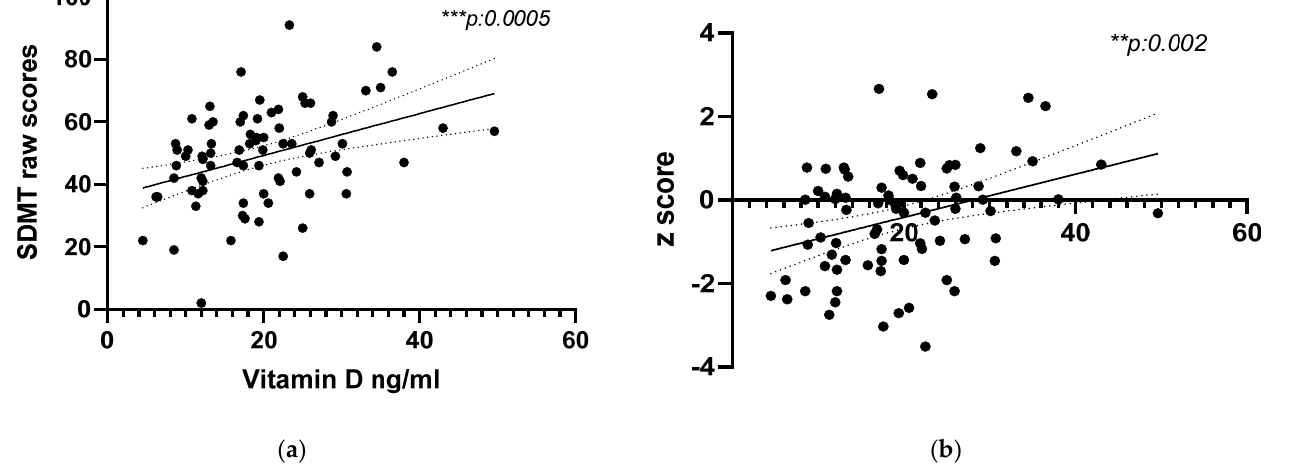
Figure 2. Correlation between serum vitamin D and SMDT raw values ( a ) and z − scores ( b ). SDMT is the neuropsychological test used to evaluate information processing speed. z − scores are normalized scores obtained after correction for age, sex, and educational levels according to the Italian normative values. We found a statistically significant positive correlation in both cases ( r s: 0.38, p − value: 0.0005; r s: 0.33, p − value: 0.002).